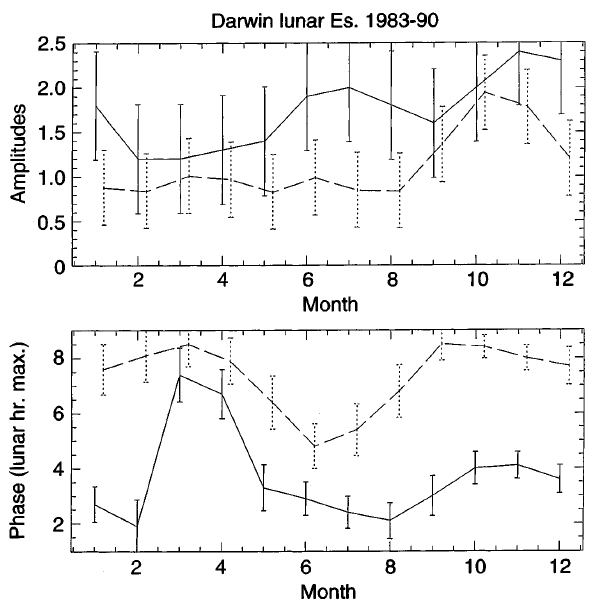
Fig. 7. Variation of amplitude and phase with season of the lunar tide in Es at Darwin. Data are from 1983 to 1990. Other details are the same as Fig. 6